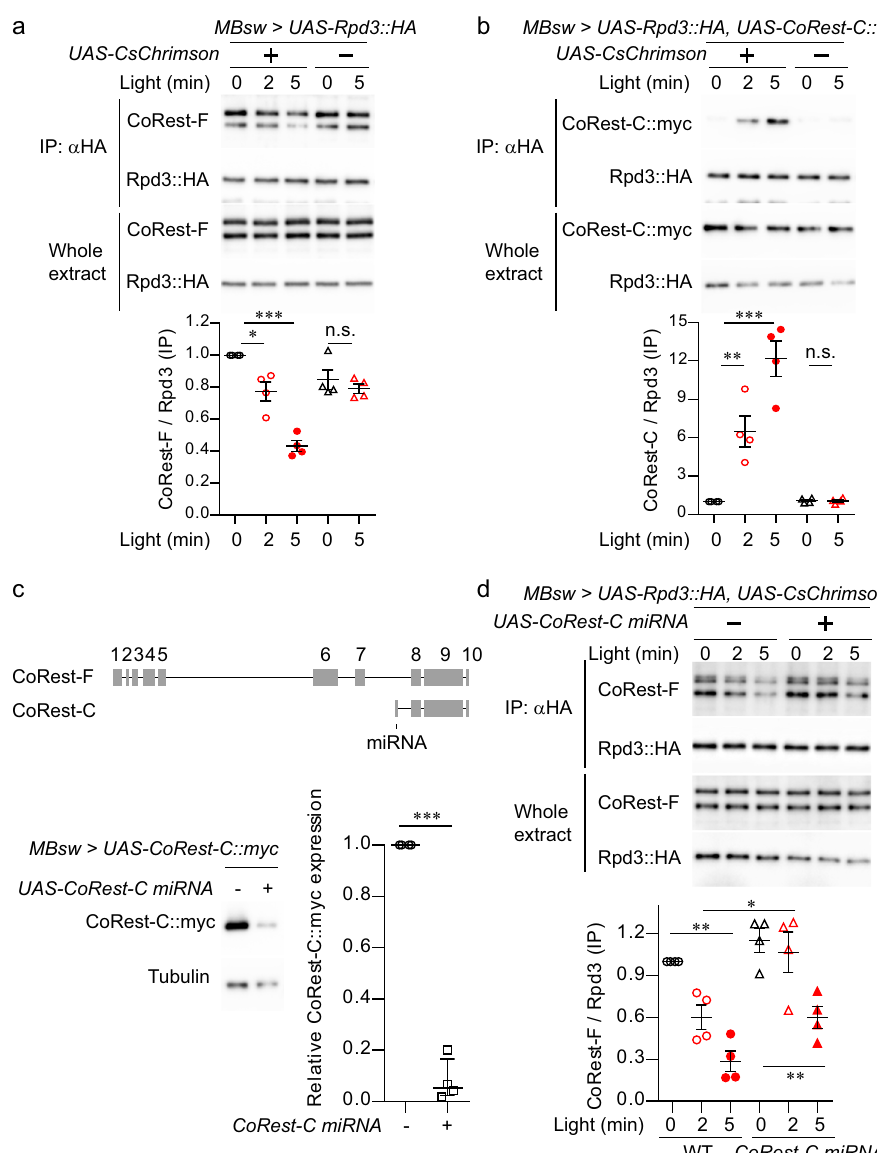
Fig. 2 CoRest-C is required for the dissociation of Rpd3/CoRest-F. a , b , d CoRest-F or CoRest-C binding to Rpd3 after neural activation. Flies with the indicated transgenes were fed RU, and illuminated with red light, and the head extracts were immunoprecipitated with the anti-HA antibody. CoRest-F was detected with the anti-CoRest antibody ( a , d ), and other proteins were detected with antibodies speci fi c to the indicated epitope tags in a western blot analysis. One-way ANOVA ( P < 0.0001; n = 4 for all) followed by Tukey ’ s multiple comparisons (two sided) were performed. c CoRest-C was knocked down with miRNA targeted to the speci fi c exon in CoRest-C. The vertical gray bars indicate the exons, and the horizontal lines indicate the region of the introns. The fl ies carrying the indicated transgenes were fed RU for 3 days, and the head extracts were analyzed by a western blot analysis with anti-myc and anti-tubulin antibodies. The amount of tubulin was used for normalization. Two-sided Mann – Whitney U -test, P = 0.0002; n = 4. Data are represented as mean ± s.e.m. n.s., not signi fi cant, P > 0.05; * P < 0.05; ** P < 0.01; *** P < 0.001, which is based on experimental replicates using different pooled samples, and the number is indicated as n above. Source data are provided as a Source Data fi